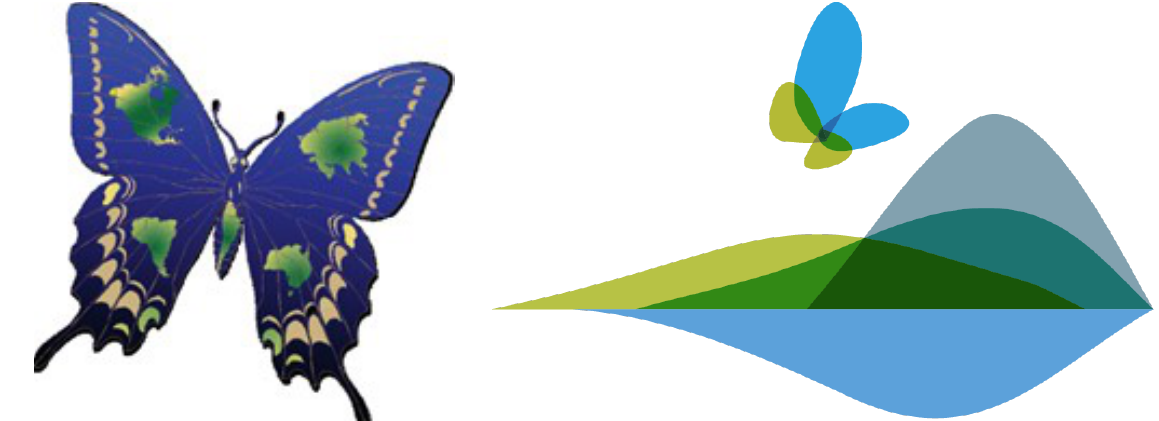
Figure 3. The metamorphosis of the Frontiers of Biogeography logo. The original logo, coming from the Frontiers of Biogeography book (Lomolino & Heaney 2004), was an artist’s rendering of Bernard Cahill’s 1909 “butterfly map” of the world, one of many projects to transform Earth’s sphere into a planar surface. Frontiers’ new logo feeds on the theme created for the new IBS corporate image, and represents four overlapping hypervolumes in the form of a butterfly’s wings, flying over four niche response curves in the form of hills, mountains and the sea. This change is a metaphor for the substantial transformation that biogeography has undergone from over a century of growth, from describing geographical patterns to studying the shifting balance of processes that shape aspects of biodiversity in different realms, such as species niches, dispersal, ecological interactions, and evolutionary